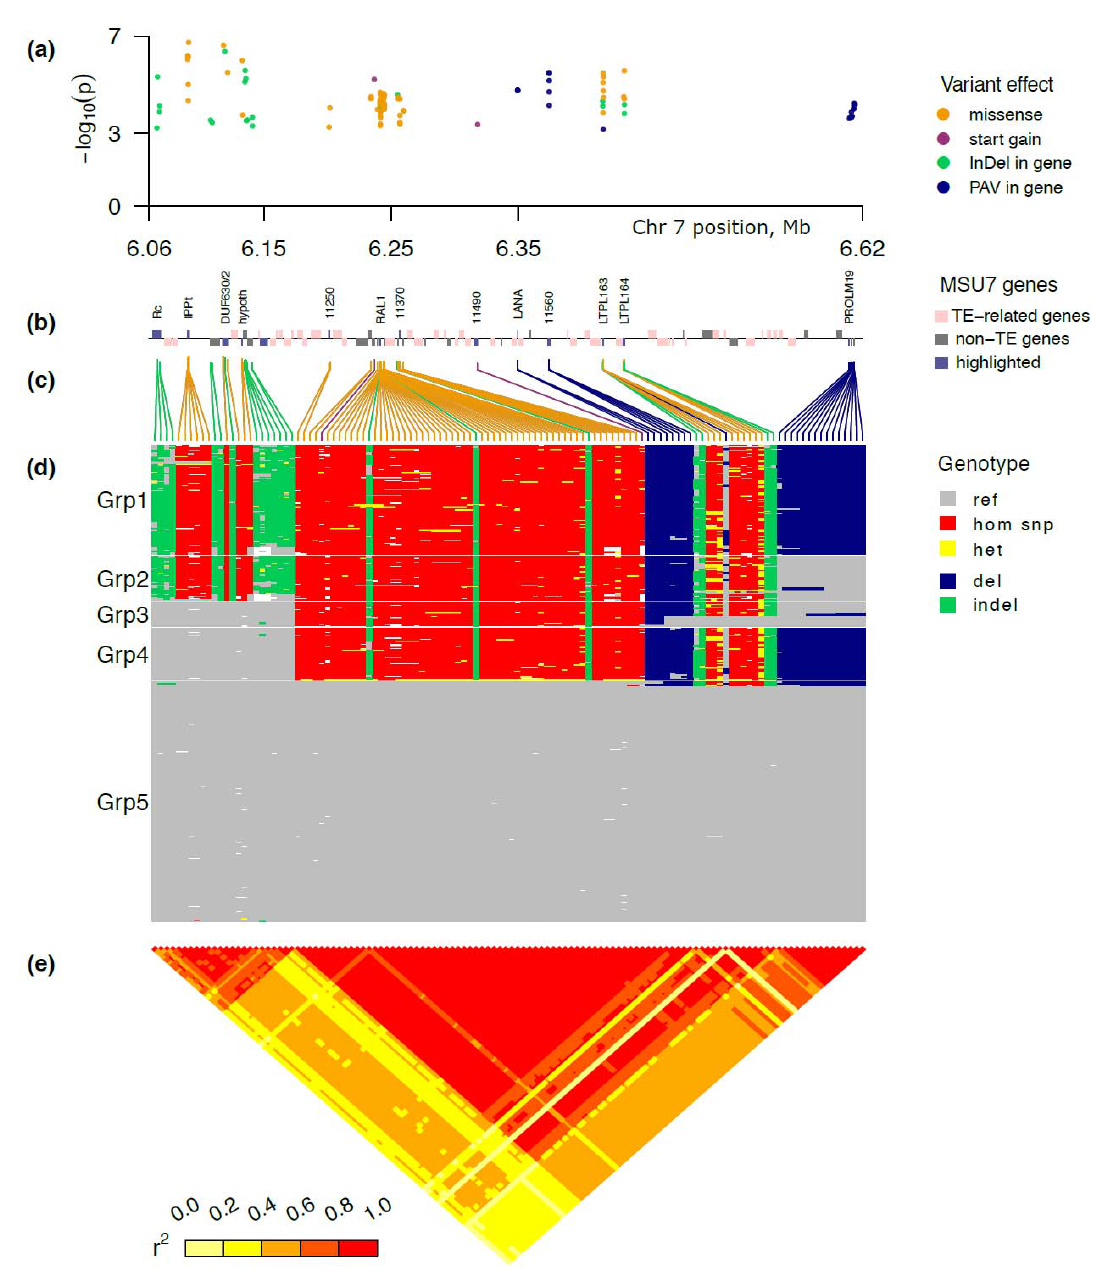
Figure 3. A close-up view of AG2 peak region on chromosome 7. ( a ) The Manhattan plot shows the level of significance for SNPs correlated with AG tolerance from the GWAS analysis (numbers across the x-axis indicate the chromosome). ( b ) The gene track identified within the region (above line—positive strand, below line—negative strand, light red—transposable elements, genes marked blue are some of the selected candidate genes). The annotation is taken from MSU7, numbers like 11560 mean LOC_Os07g11560. ( c ) Lines connecting physical position plots ( a , b ) with consecutive variant plots ( d , e ). The color of lines shows the effect (orange—nonsynonymous SNP, green—small indel, blue—large deletion or its part). ( d ) Graphical genotype plot (columns are variants, rows are samples, genotypes are color-coded according to legend in the bottom; the samples are ordered and grouped by hierarchical clustering). ( e ) LD heatmap of the region using r 2